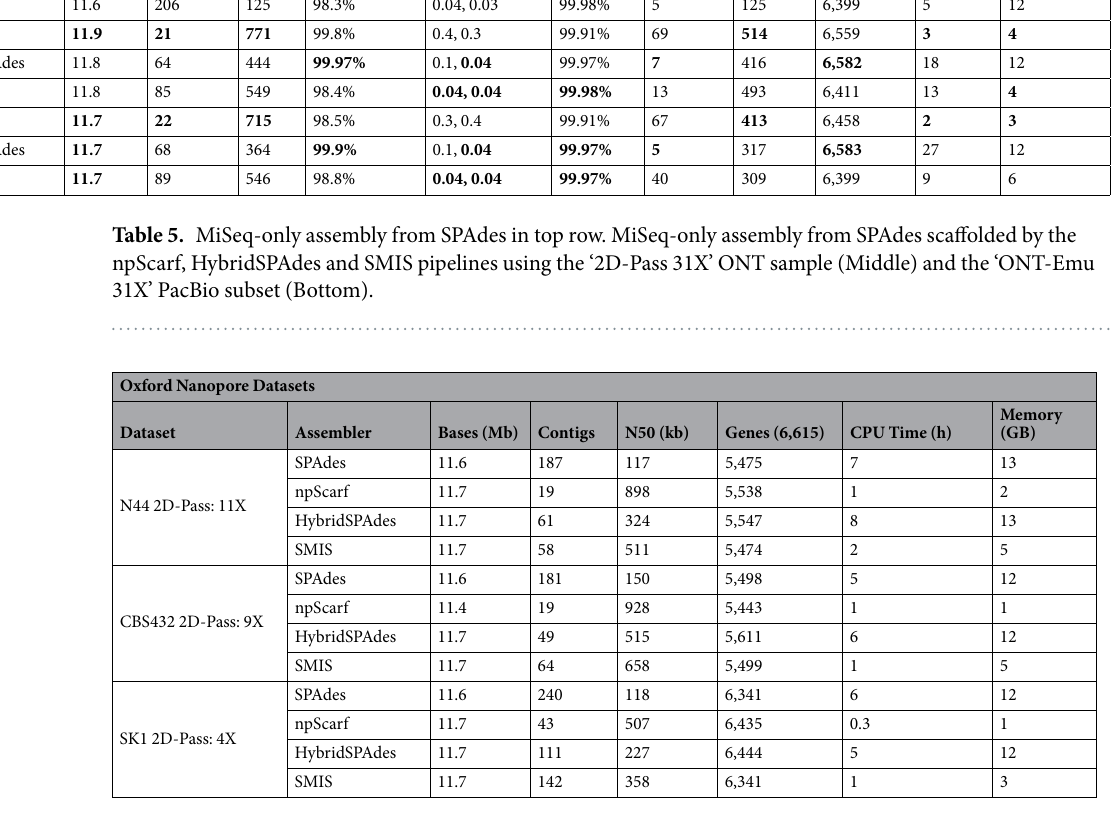
Table 6. Statistic information on the de novo assemblies from the MiSeq-only SPAdes pipeline and the same SPAdes assembly scaffolded with npScarf, HybridSPAdes and SMIS for the N44 (top panel), CBS432 (middle panel), and SK1 (bottom panel)